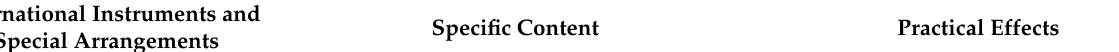
Table 1. Examples of international legal measures, initiatives, frameworks, and special arrangements for improving COVID-19 vaccine production in